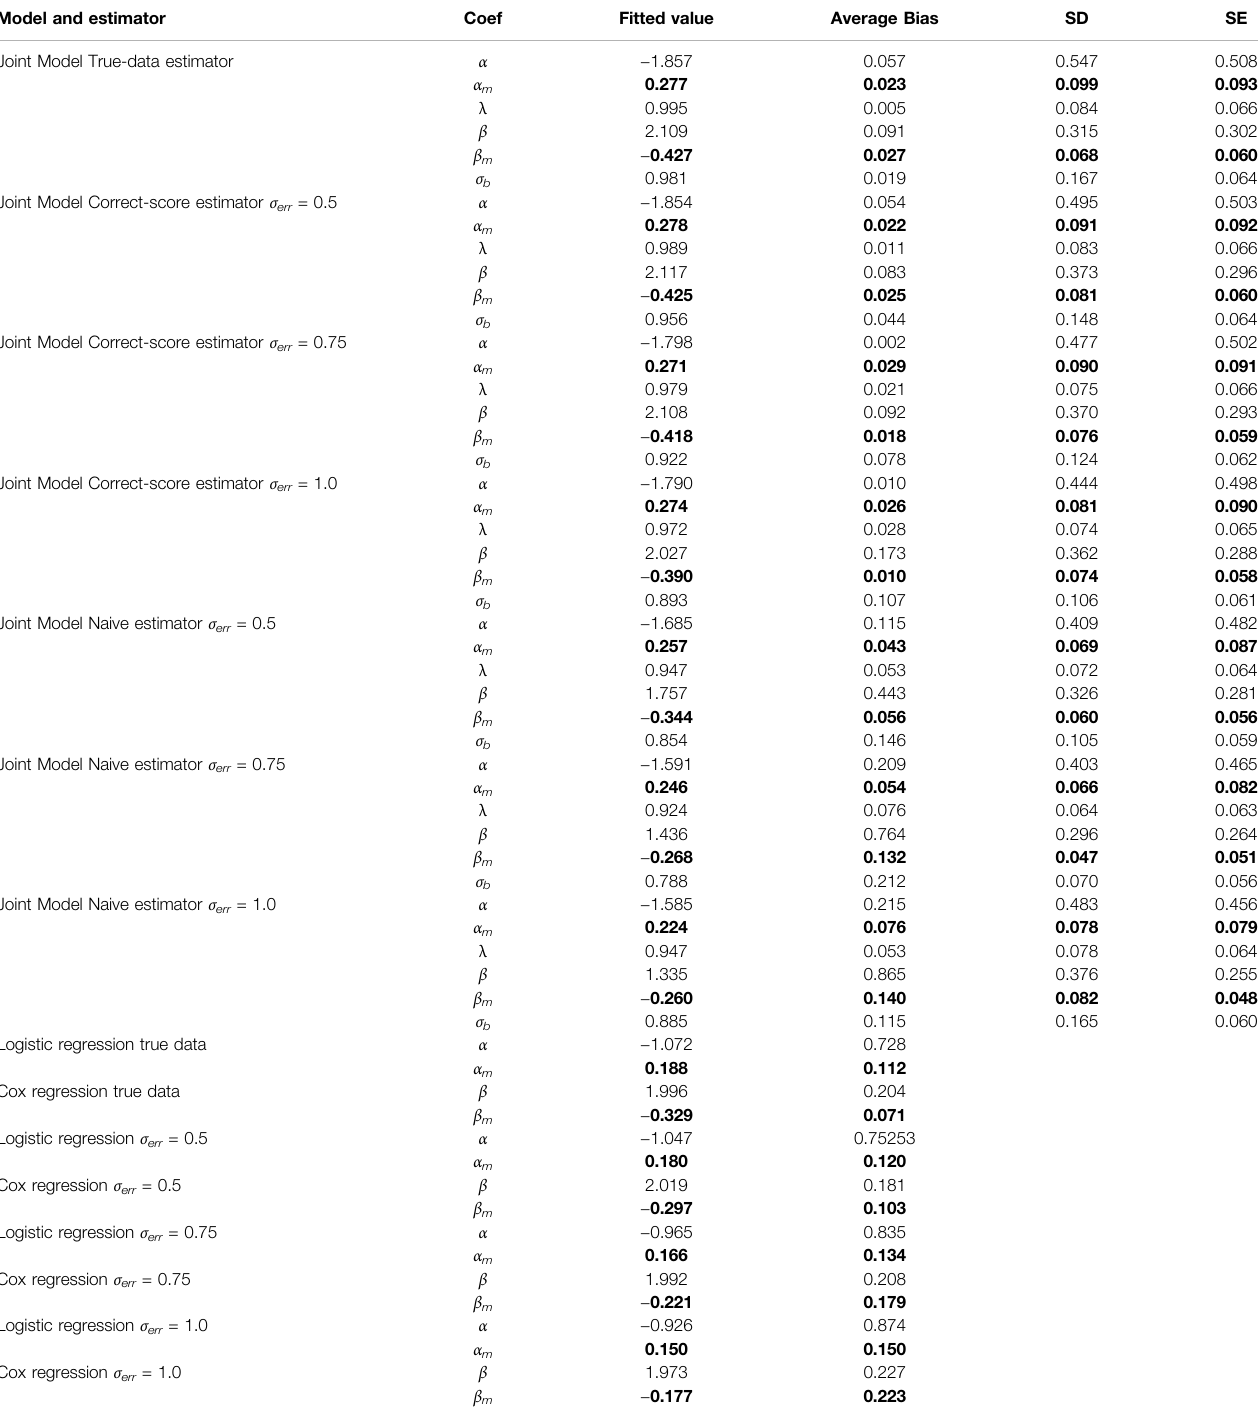
TABLE 1 | Comparisons of bias and standard errors of estimators between joint model with standard model with varying measurement errors. Model and